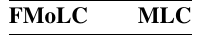
Table 2. The average computation time for parameter estimation using the whole scenarios.